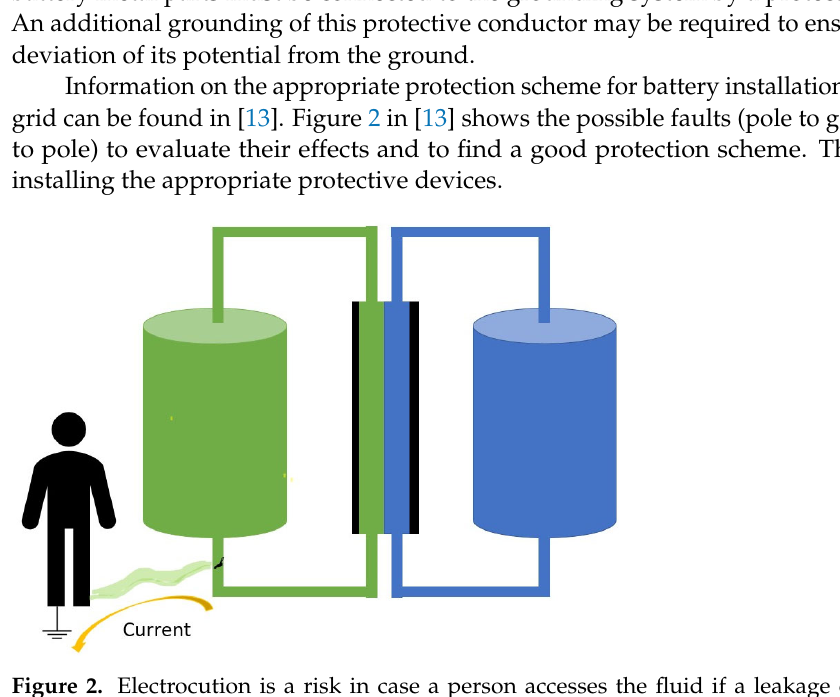
Figure 2. Electrocution is a risk in case a person accesses the fl uid if a leakage of liquids from piping